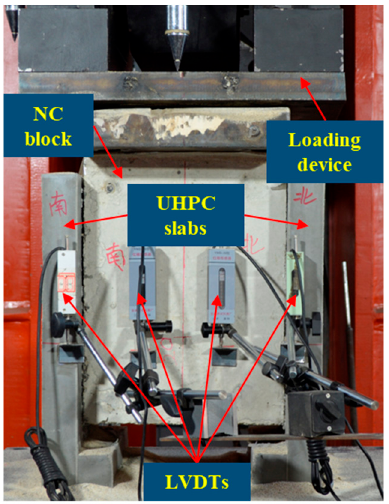
Figure 3. Test setup for push-out